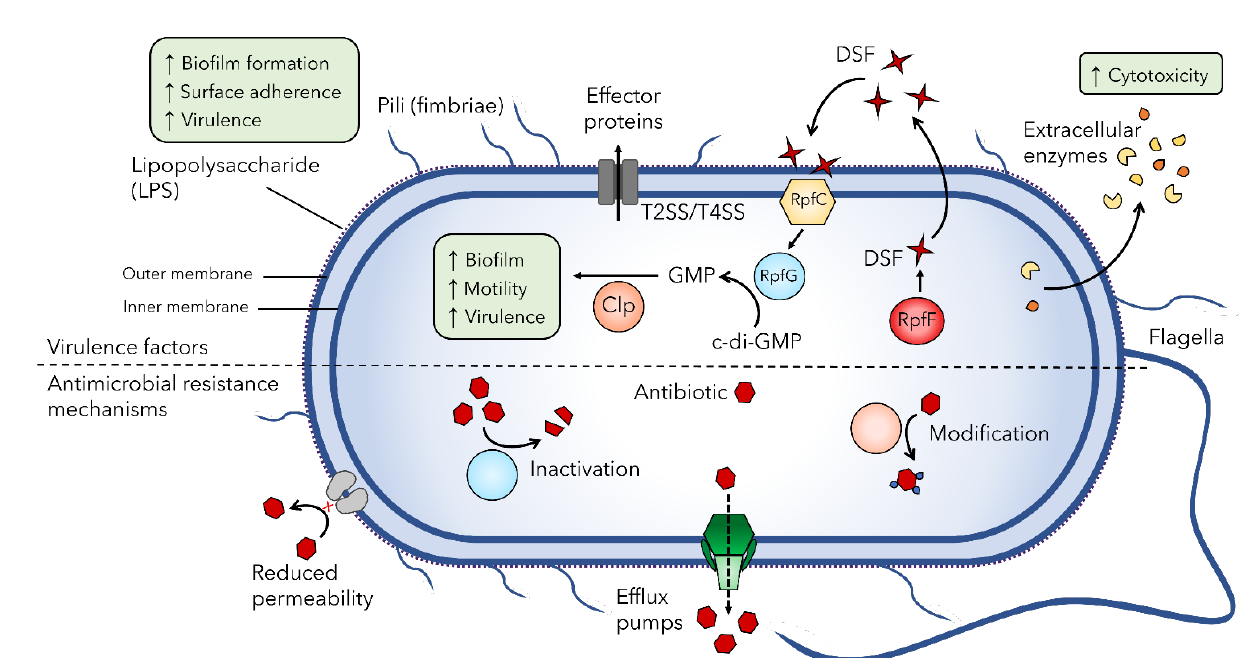
Figure 2. S. maltophilia pathogenicity and antibiotic resistance mechanisms. S. maltophilia encodes many virulence factors that contribute to its pathogenicity. Hydrolytic enzymes (yellow and orange shapes) released from the cell and secreted effector proteins contribute to cytotoxicity. Surface structures such as LPS, flagella, type IV pili, and SMF-1 fimbriae help the bacterium adhere to surfaces and form antibiotic resistant biofilm communities, contributing to increased virulence. Quorum sensing via diffusible signal factors (DSF, red stars) induces downstream gene expression shown to increase biofilm, motility and the virulence factors described. The extreme multidrug resistance of this bacterium is due to numerous mechanisms, including reduced membrane permeability, numerous chromosomally encoded efflux pumps, β -lactamases, and aminoglycoside-modifying enzymes. Antimicrobial molecules are represented by red hexagons.